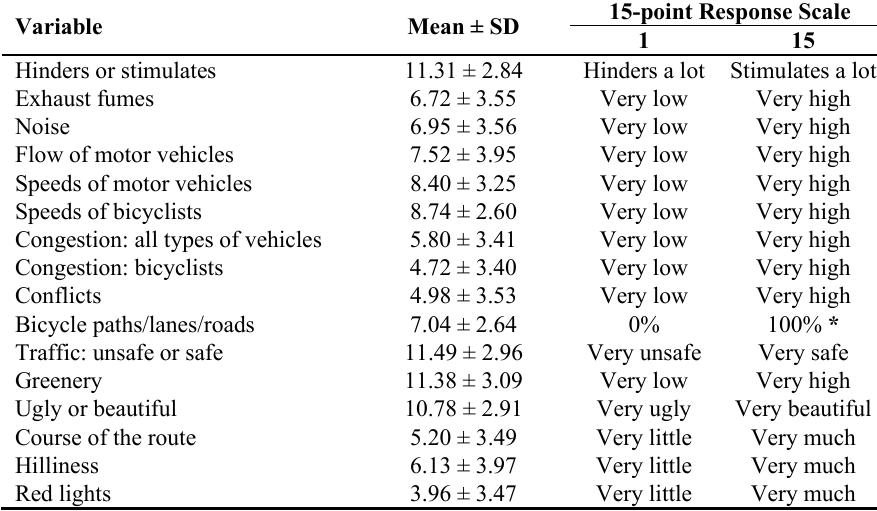
Table 3. Participants’ ratings of environmental variables (n =